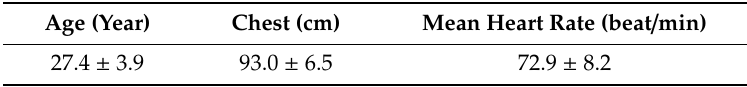
Table 2. Summary of the subjects’ characteristics (mean ± standard